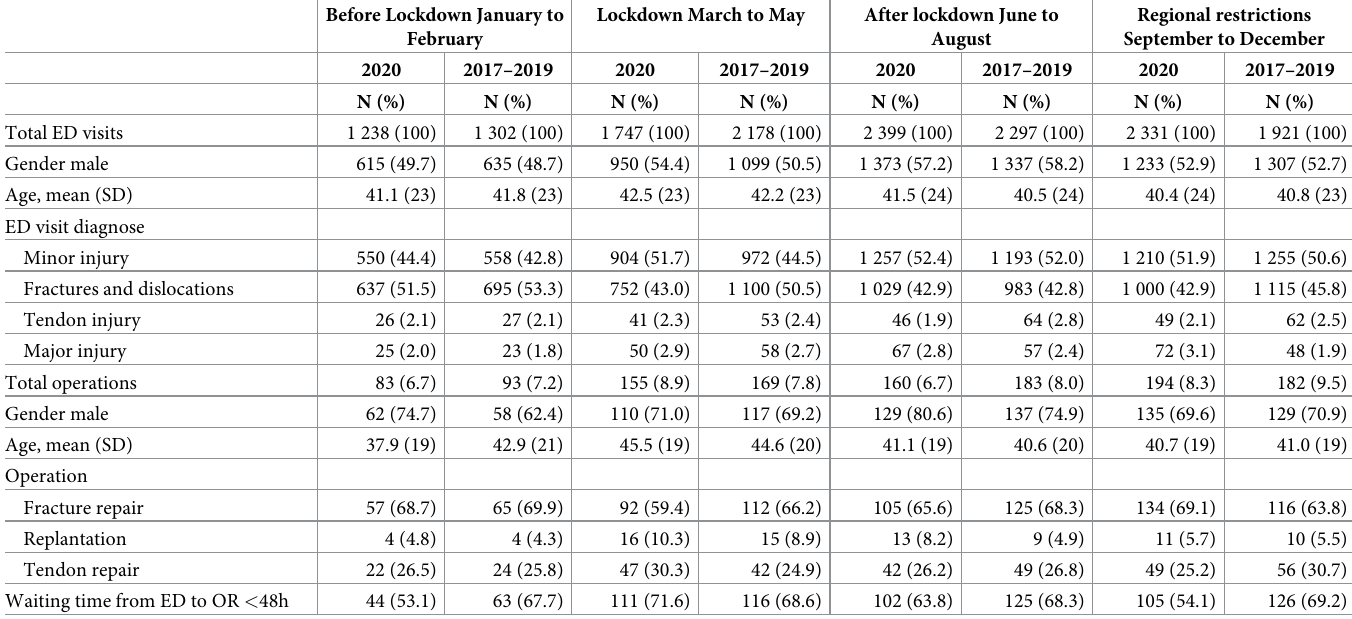
Table 2. Demographic data of the ED visits due hand injuries and subsequent hand operations, 2020 compared with mean of reference years 2017–2019. Time strat- ified by the national lockdown and regional restrictions in effect during the first and second waves of COVID-19 pandemic in